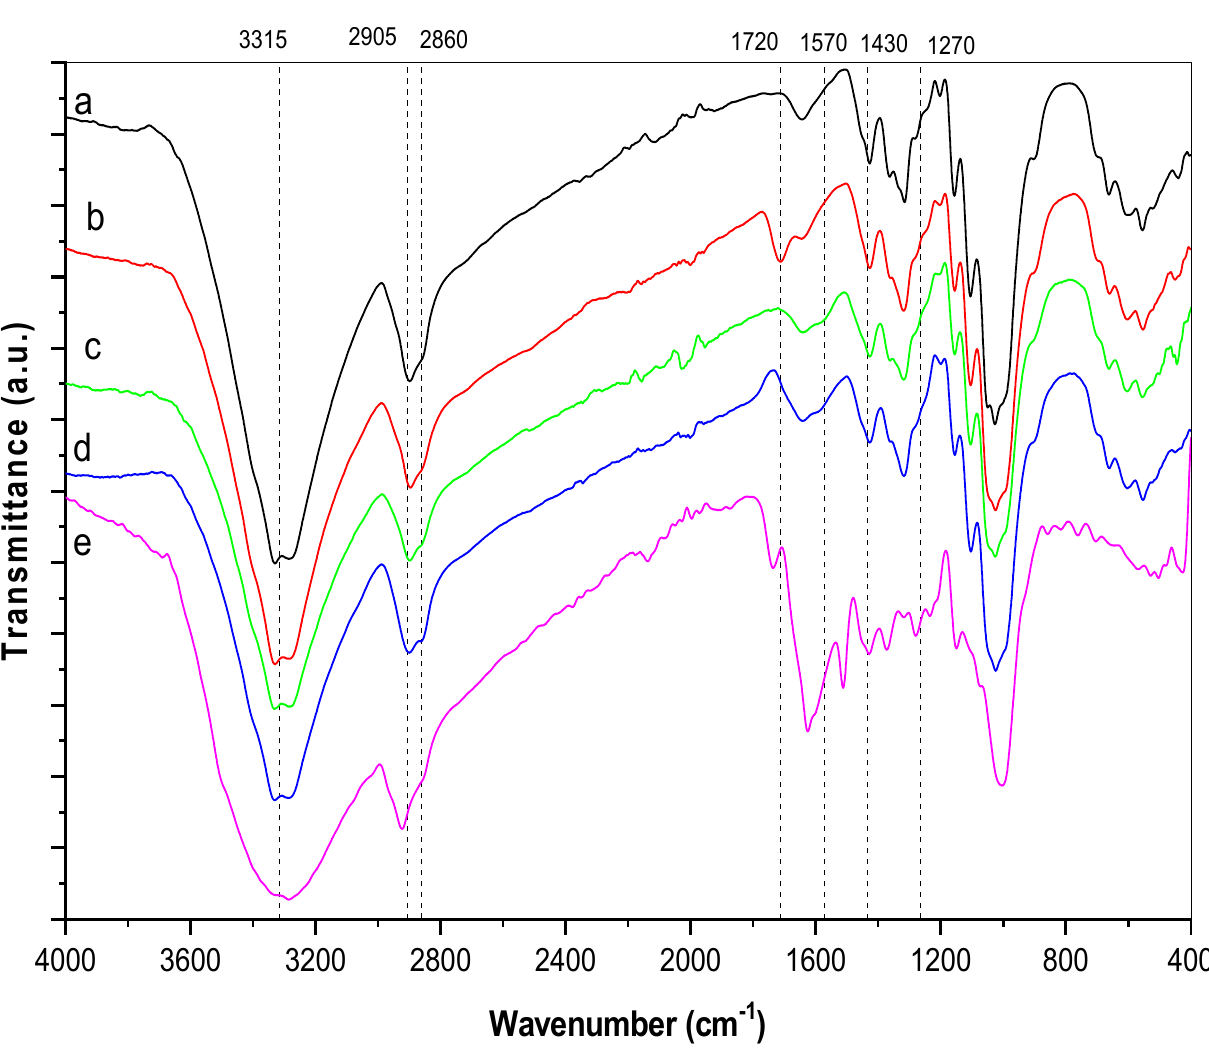
Figure 2. FTIR spectrum of untreated cotton fabric ( a ), curcumin/TiO 2 –citric-modified cotton fabric ( b ), curcumin/TiO 2 – Quat 188-modified cotton fabric ( c ), curcumin/TiO 2 –GPTMS-modified cotton fabric ( d ), and curcumin powder ( e ).